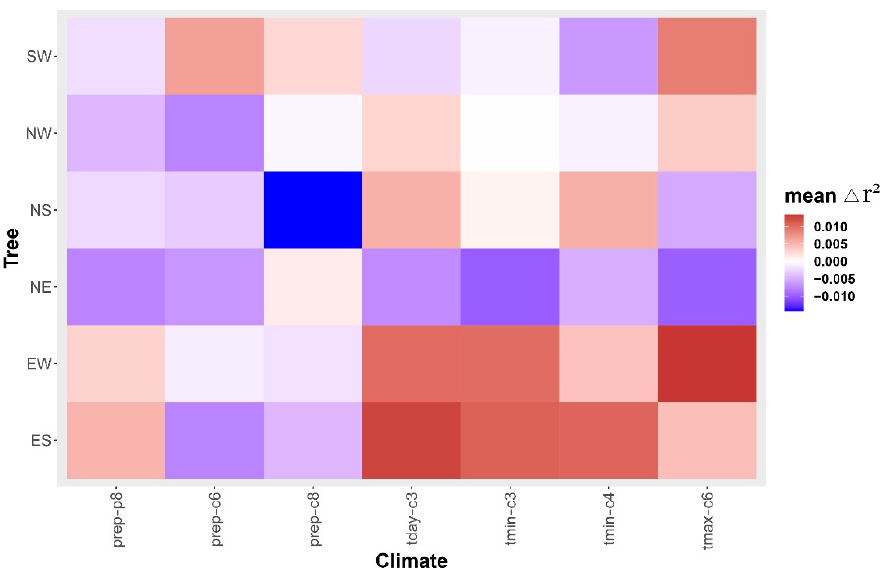
Figure 6. Mean ∆ r 2 between southern and western (SW), northern and western (NW), northern and southern (NS), northern and eastern (NE), eastern and western (EW), eastern and southern (ES) cores climate–growth correlations. ∆ r 2 is obtained by subtracting r 2 of the direction represented by the last letter (abbreviation of direction) from r 2 of the direction represented by the previous letter.